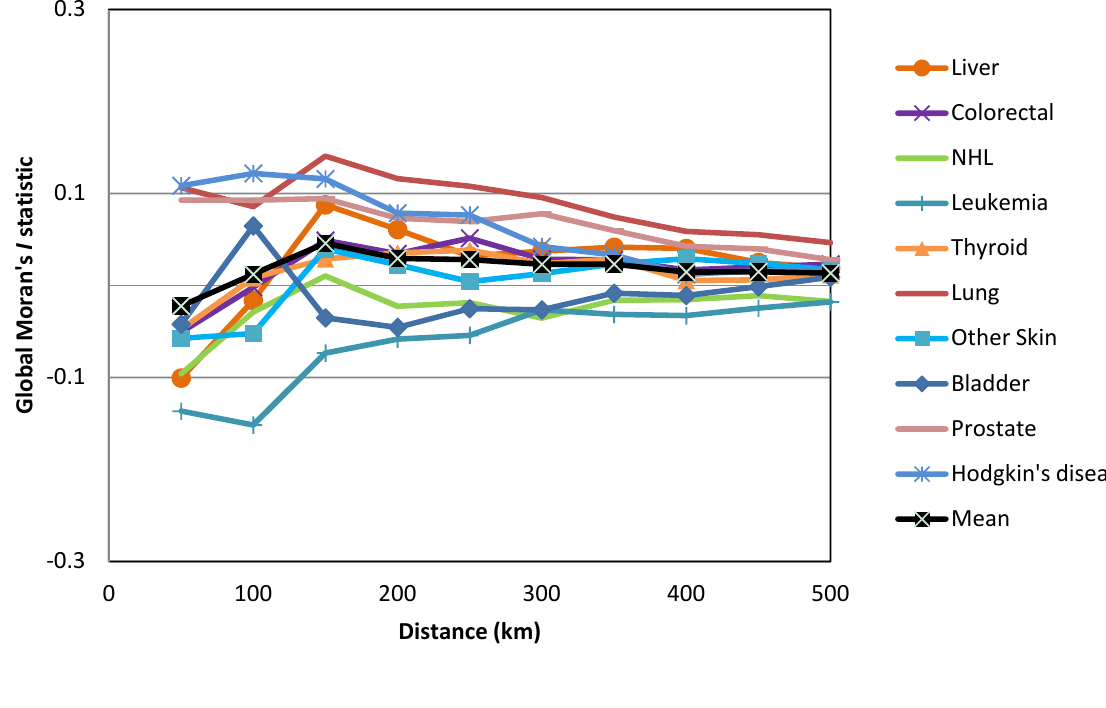
Figure 1. Global Moran’s I statistics for the most common cancers in